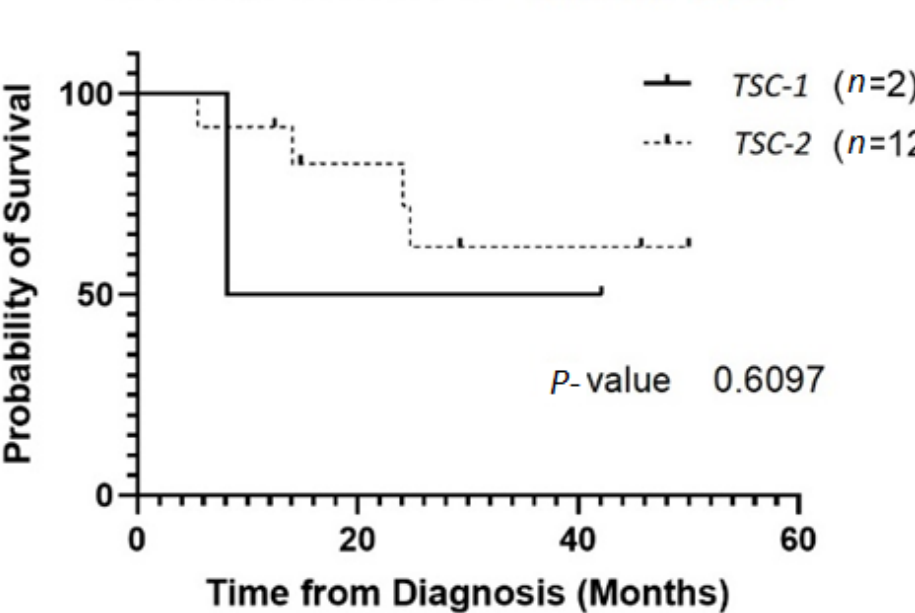
Figure 1. OS of patients with TSC-1 versus TSC-2 mutated tumors. Two patients had TSC-1 mutations and 12 patients had TSC-2 mutations. Four of the TSC-2 mutated tumors were treated with local resection without systemic therapy without recurrence. Only one of the TSC-1 mutated tumors received mTOR inhibition. Abbreviations: OS, overall survival; TSC, tuberous sclerosis complex.